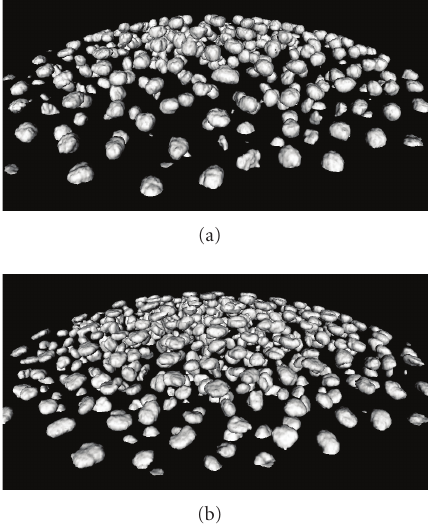
Figure 8: Segmentation of first and last volume of time lapse series.